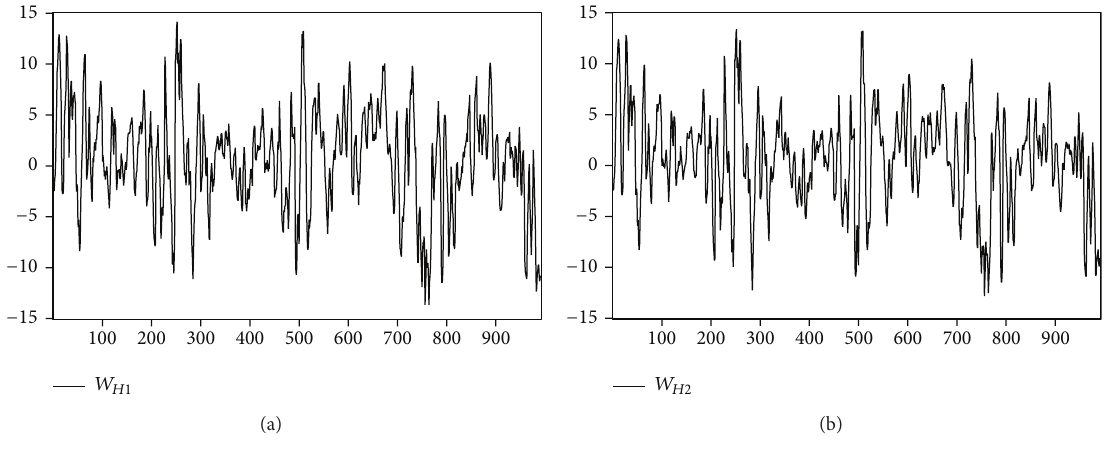
Figure 4: Temperature shock variable for heating